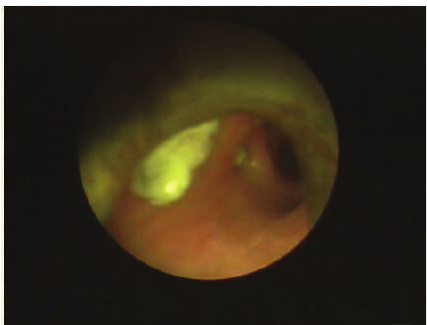
Figure 3: Bronchoscopic appearance of tumorous EBTB covered with whitish necrotic tissue, mimicking a malignant mass.